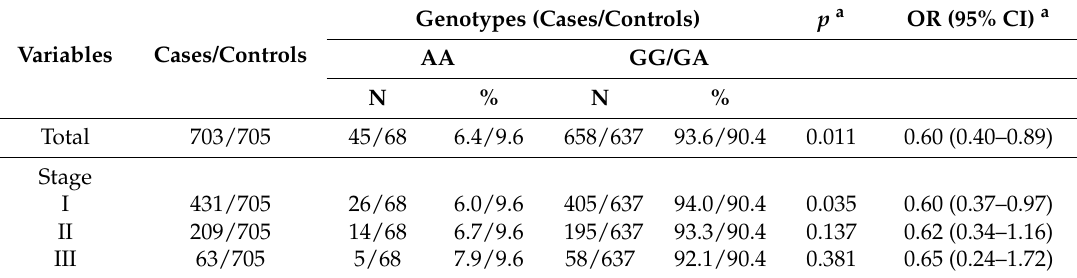
Table 5. Stratified analysis between the genotypes of LRBA rs2290846 and CWP